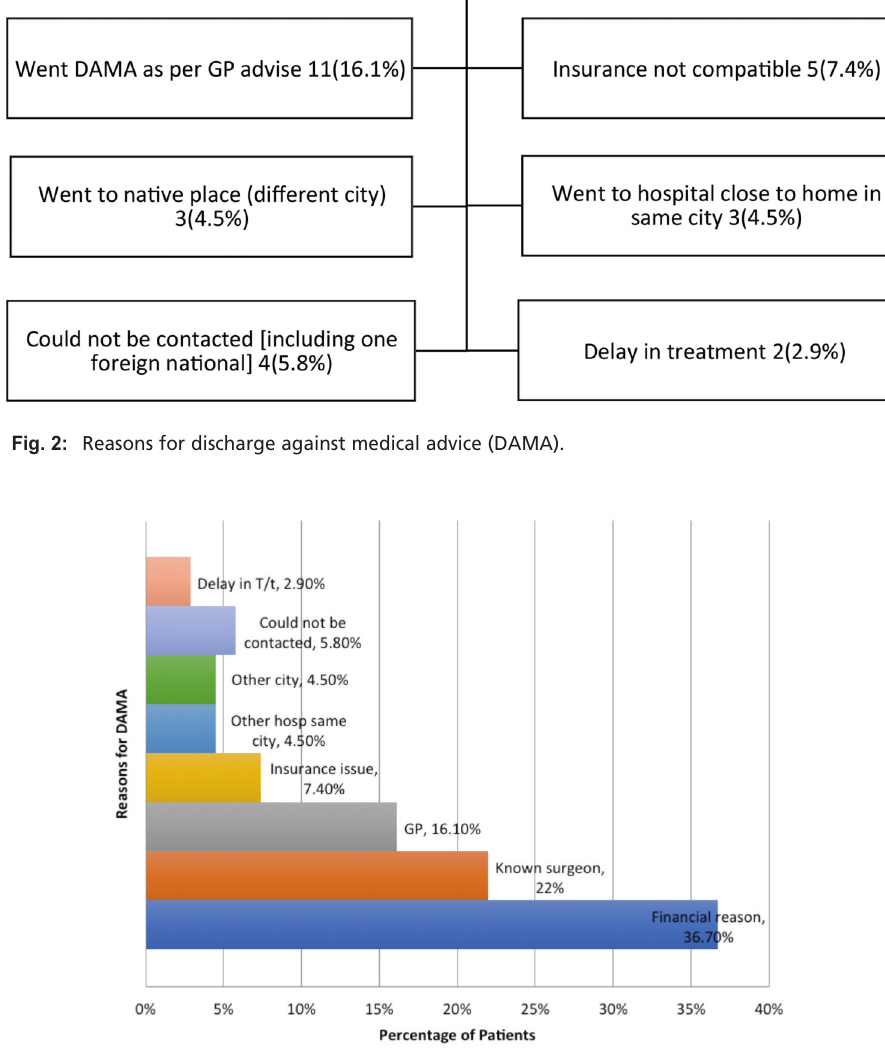
Bar chart depicting percentage distribution of reasons for Fig. 3: